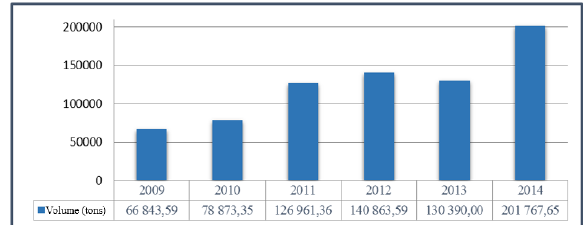
Figure 3: Volume of placed products on the Austrian market 2009– 2014